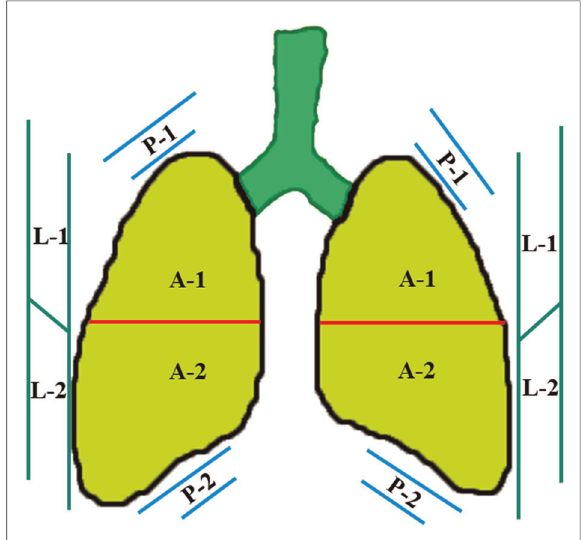
FIGURE 1 Divisions of the lung fi eld. Each hemithorax can be separated into three regions by the anterior and posterior axillary lines, including the anterior (A) region, lateral (L) region, and posterior (P) region. In respect to each region, it can be further separated into an upper and a lower region.